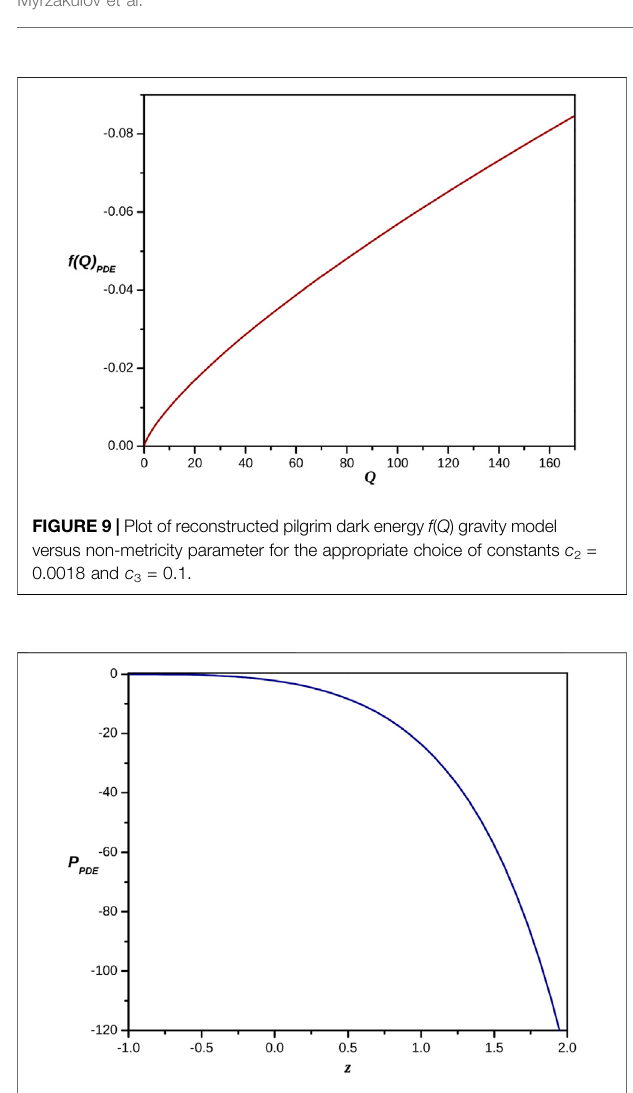
FIGURE 10 | Plot of the pressure of the reconstructed pilgrim dark energy f ( Q ) gravity model versus redshift for the appropriate choice of constants.